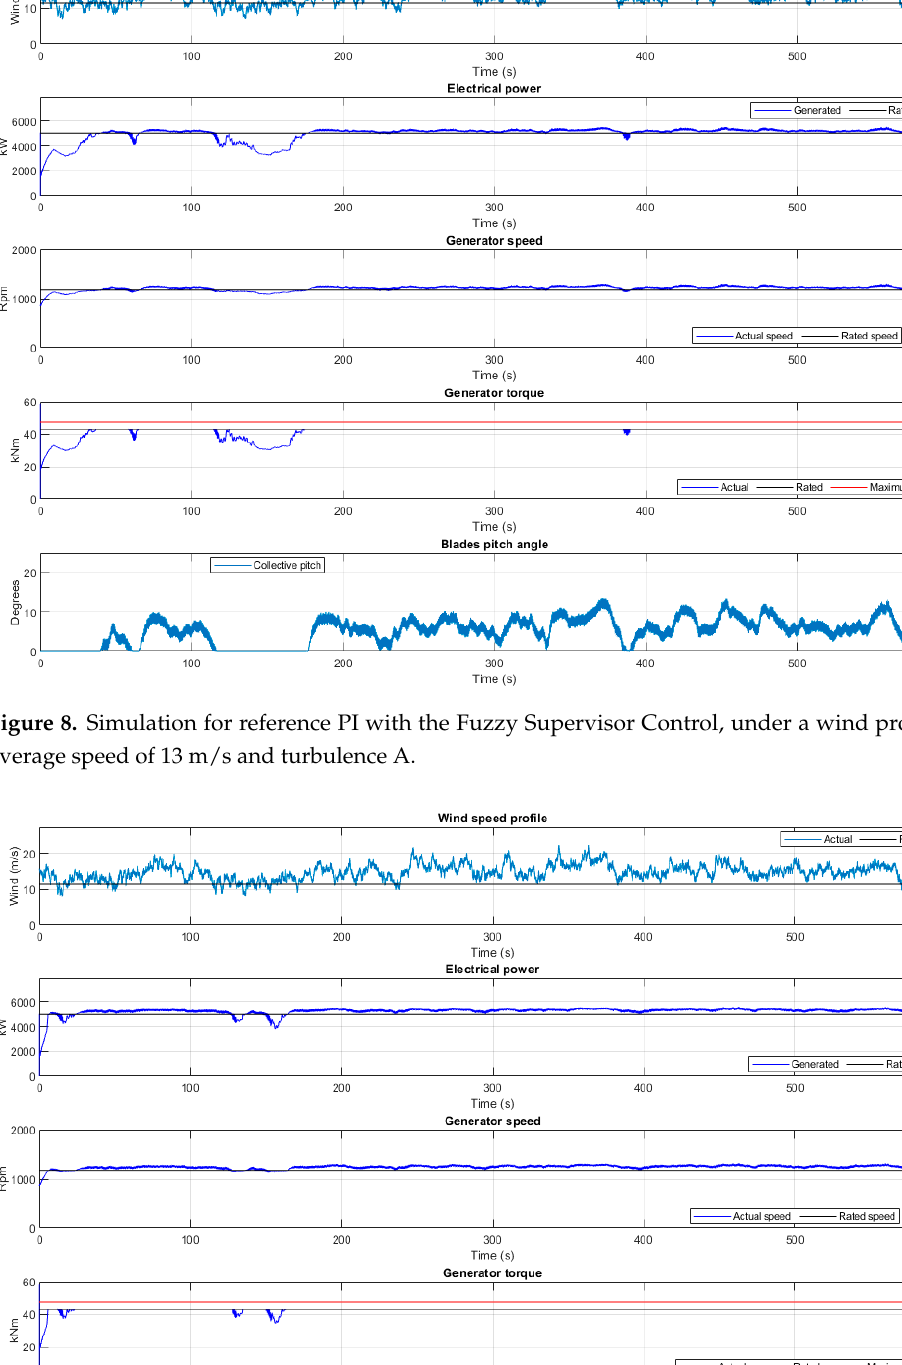
Figure 10. Simulation for reference PI with the Fuzzy Supervisor Control, under a wind profile of average speed of 18 m/s and turbulence A.